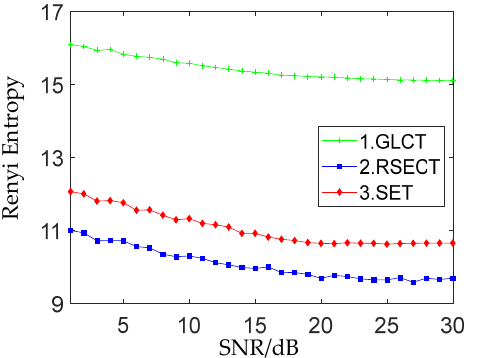
Figure 9. R é nyi entropies of the TF representations generated by three different Figure 9. Rényi entropies of the TF representations generated by three different methods.